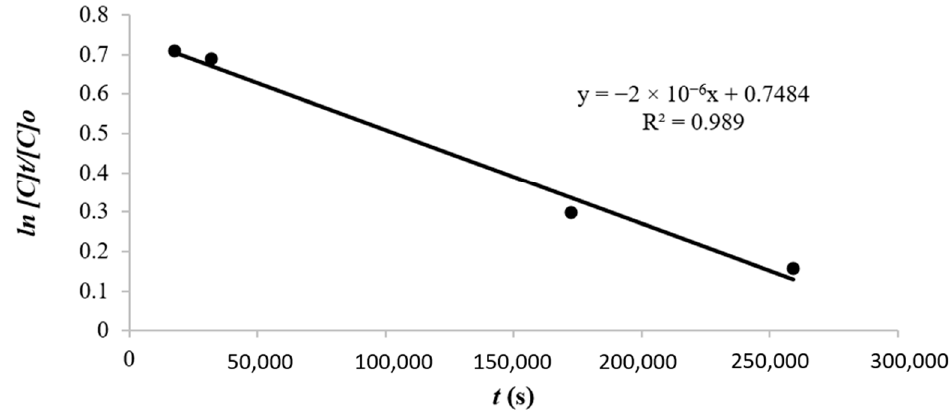
Figure 6. The curve of first-order phenol transport linear equation. Table 2. Values of first order and second order equations based on time variations .